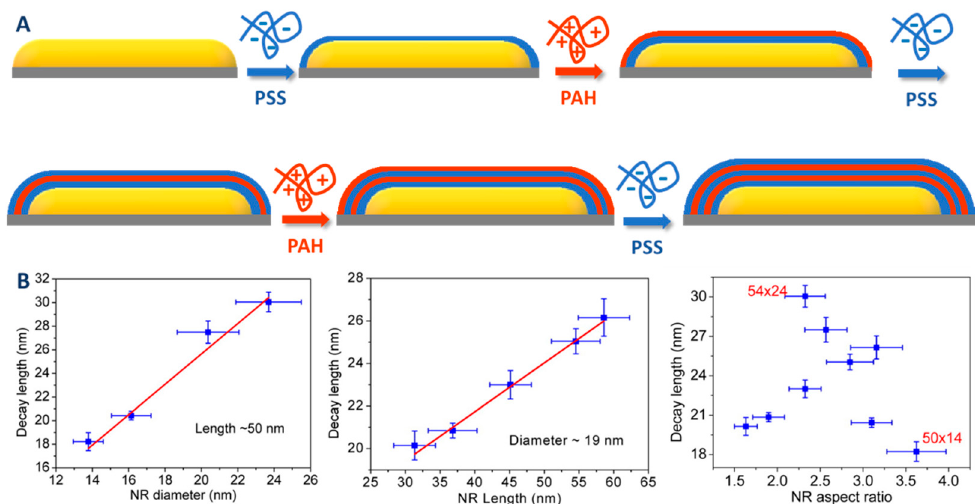
Figure 23. ( A ) Schematic representation of AuNR on a glass substrate covered with polyelectrolyte multilayers by the LBL approach. ( B ) Electromagnetic decay lengths of AuNR with different diameters, lengths and AR of AuNR, adapted from ref [194].